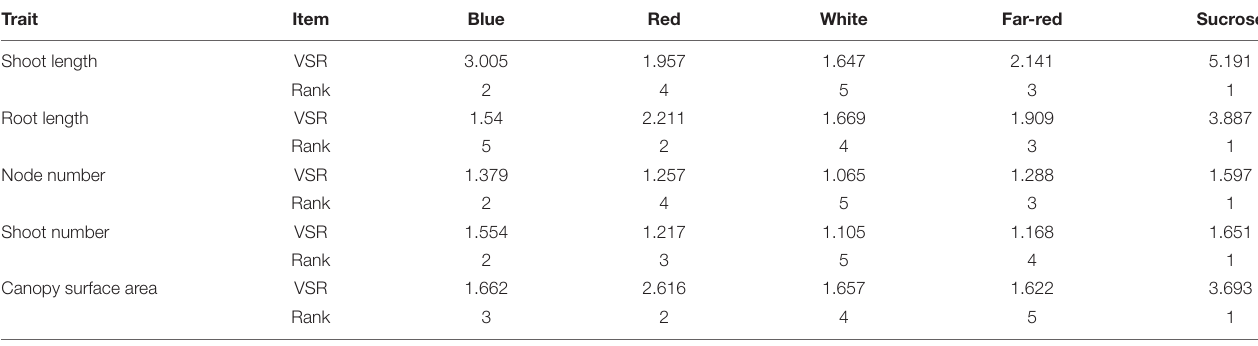
TABLE 3 | Importance degree of light (blue, red, white, and far-red) and carbohydrate sources on shoot length, root length, number of nodes, number of shoots, and canopy surface area of Cannabis through sensitivity analysis. Trait Item Red Far-red